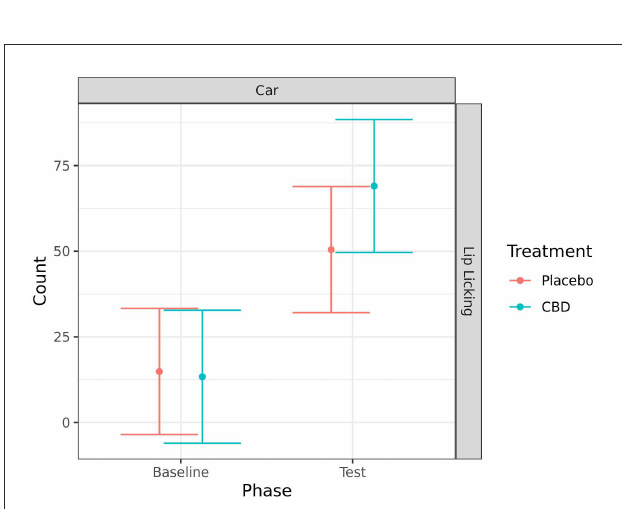
FIGURE8 Predicted mean (95% CI) number of lip licks for dogs given CBD or placebo at each phase of testing (baseline and test) during the car test. No significant differences (p < 0.05) were identified between treatment groups within each